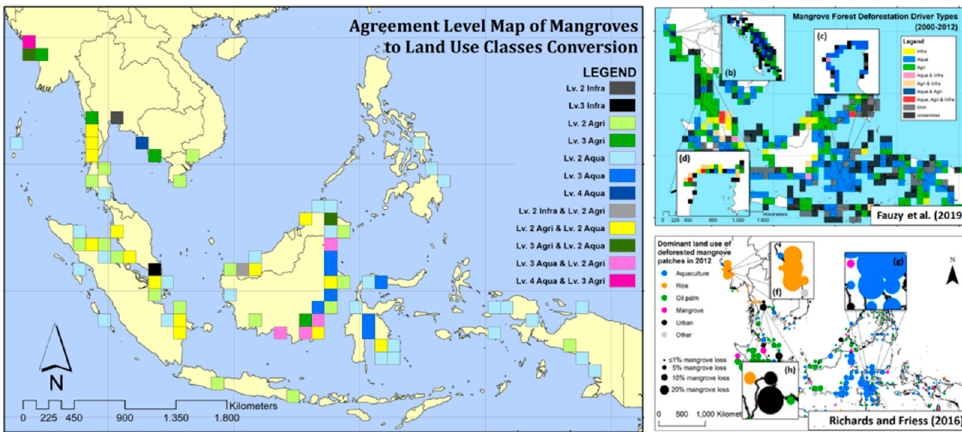
Figure 13. Comparison of mangrove forests converted to other classes at confidence levels of 3 and 4 with Dominant Land Use of Deforested Mangrove Patches (DLUDMP)-The Southeast Asian Mangroves Conversion Types (SEAMCT) from a spatial context.